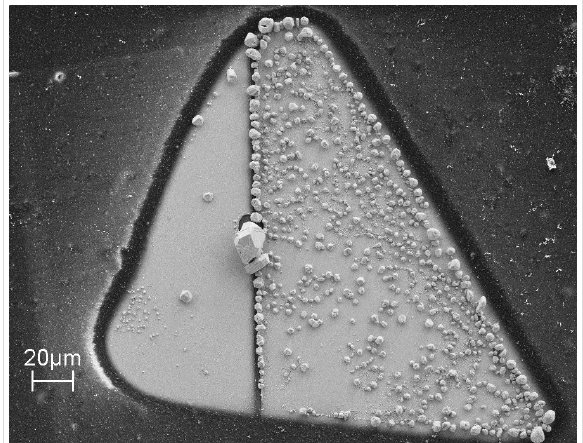
Figure 1: SEM image of the Au electrodes; the gap between the two segments, distinguishable by the border of the region covered by Ag crystallites, is somewhat left from the middle (size of the image 200 × 150 µm 2